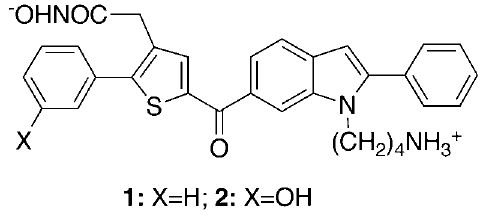
Figure 1. Chemical structures of inhibitors 1 and 2.